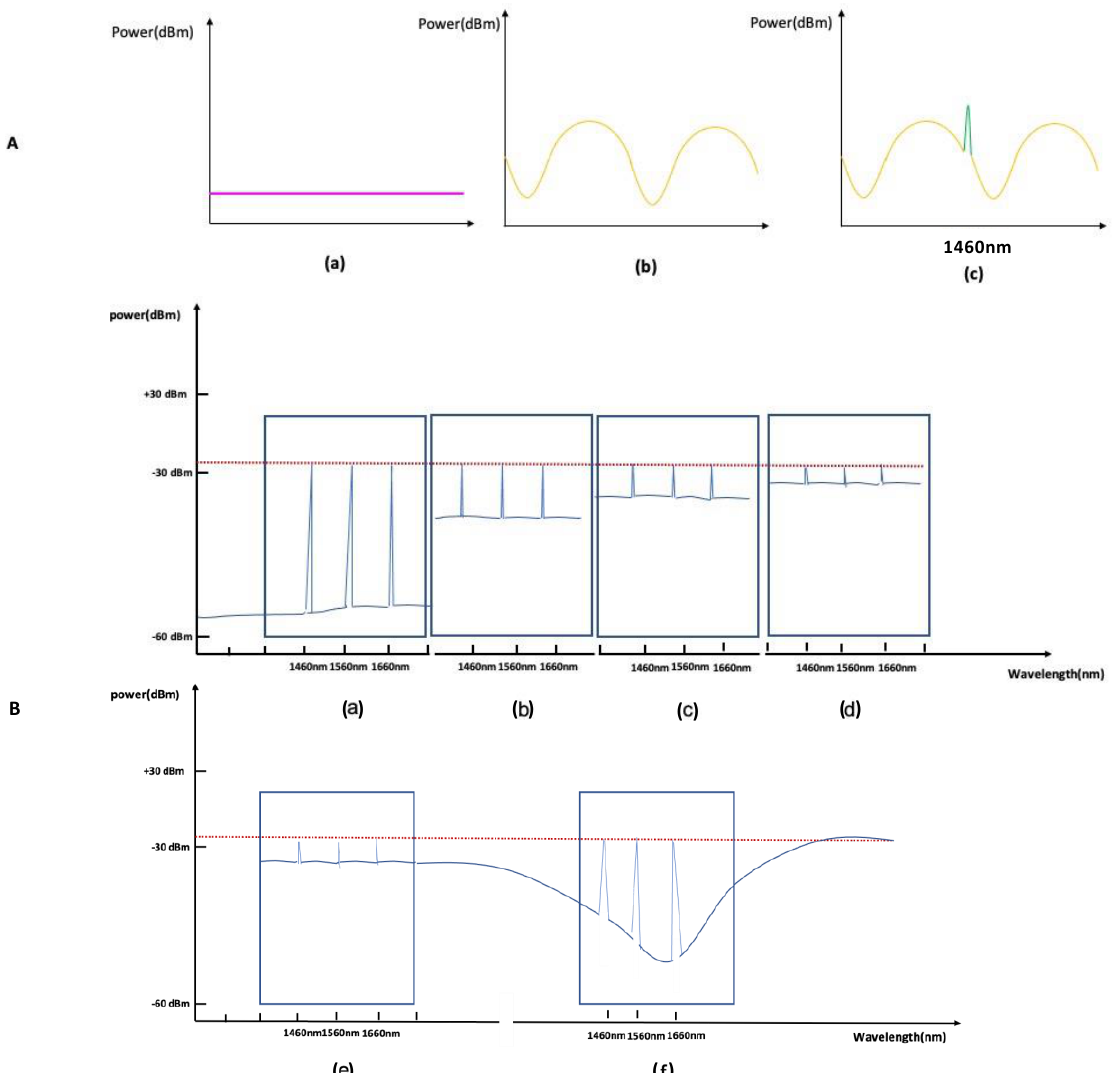
Figure 6. ( A ). (a) interrogator measurement spectrum before the grating process; (b) interrogator measurement spectrum after the long-period grating process on the entire optical fiber; and (c) grating spectrum of one point of the short-period grating between long-period gratings with a femtosecond laser. ( B ). (a) sensor Bragg wavelength spectrum with minimal light power intensity; (b) sensor Bragg wavelength spectrum with 30% light power intensity; (c) sensor Bragg wavelength spectrum with 70% light power intensity; (d) sensor Bragg wavelength spectrum at the maximum light power intensity; (e) three short-period Bragg wavelength spectra placed flat period part of the long-period grating; and (f) three short-period Bragg wavelength spectra placed on curved part of the long-period grating.